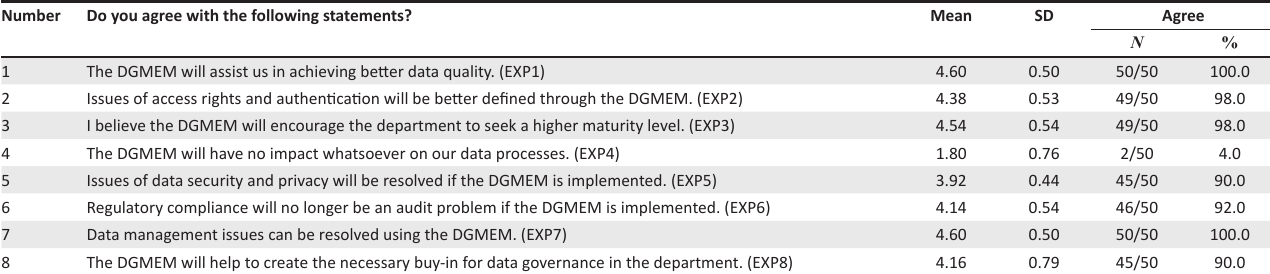
TABLE 6: Expected results of the implementation of the Data Governance Maturity Evaluation Model ( N = 50).